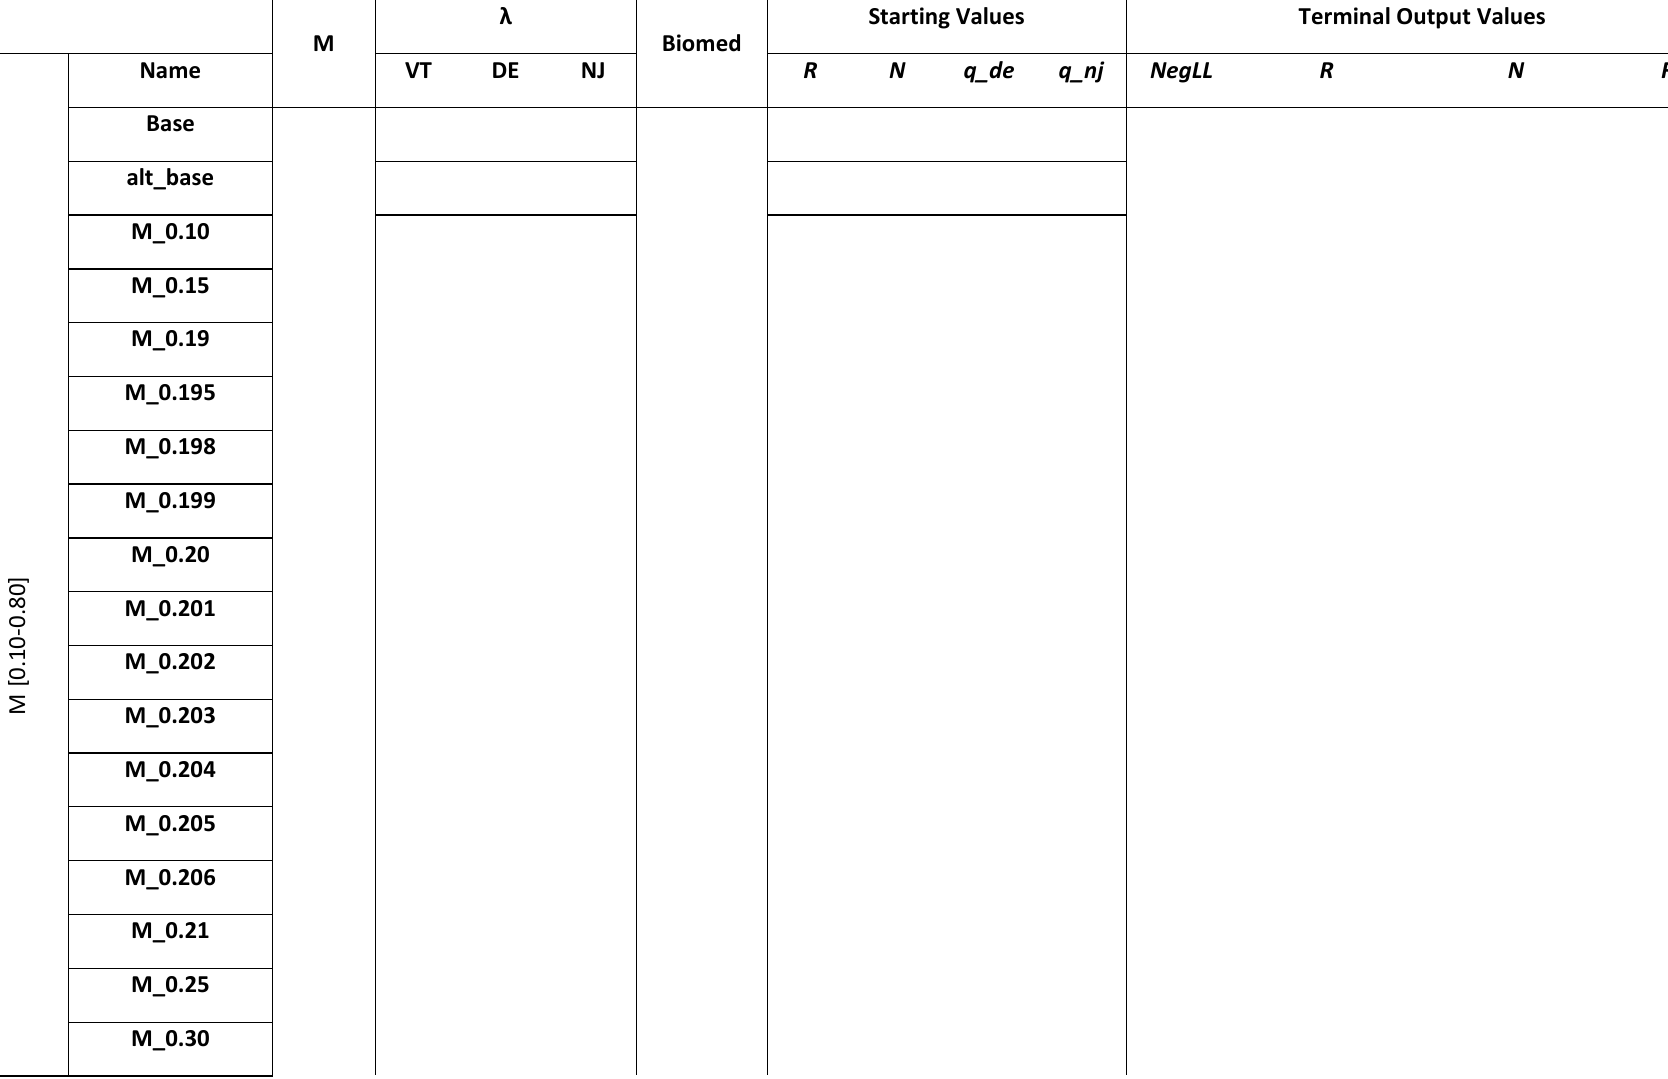
Table 47. Sensitivity runs for the catch multiple survey analysis model. All runs that included CONFIDENTIAL biomedical data have been